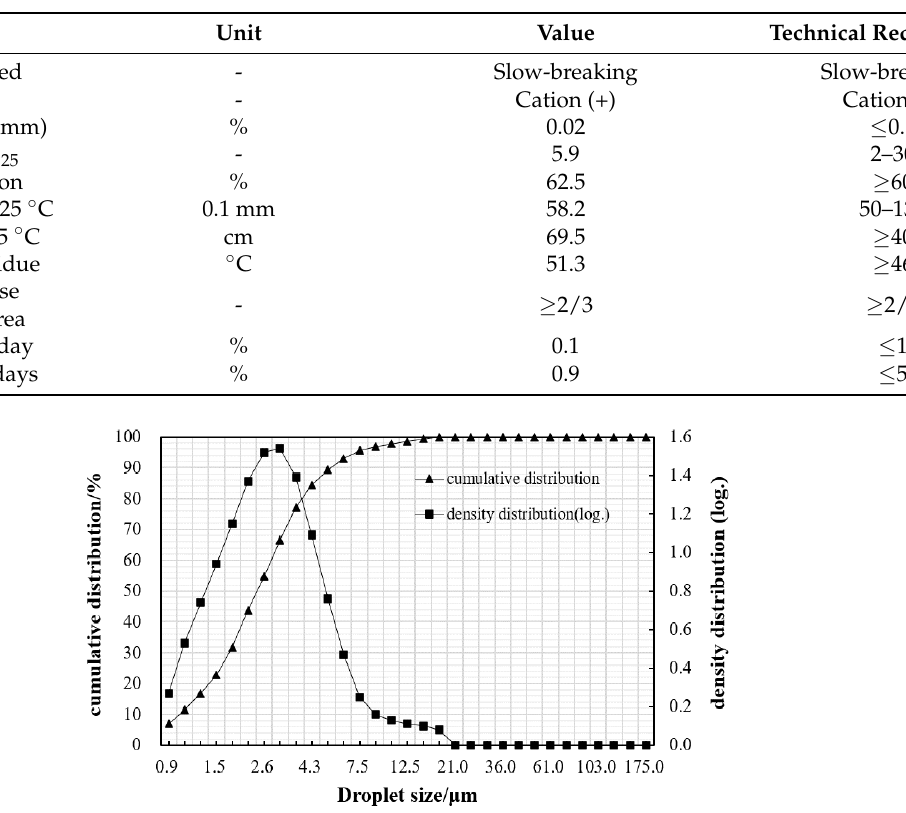
Table 3. The composition of aggregate.